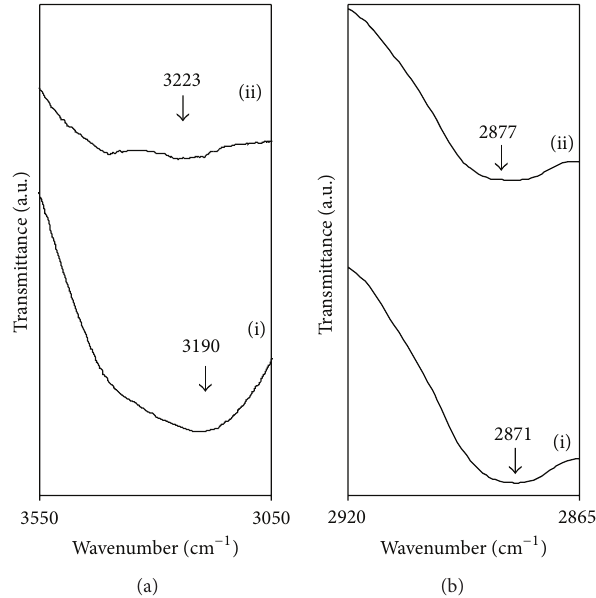
Figure 3: (a) FTIR spectra for (i) pure GO and (ii) 90 wt.% PEO-10wt.% GO blend in the region of 3050–3550 cm −1 . (b) FTIR spectra for (i) pure PEO and (ii) 90wt.% PEO-10wt.% GO blend in the region of 2865–2920 cm −1 .